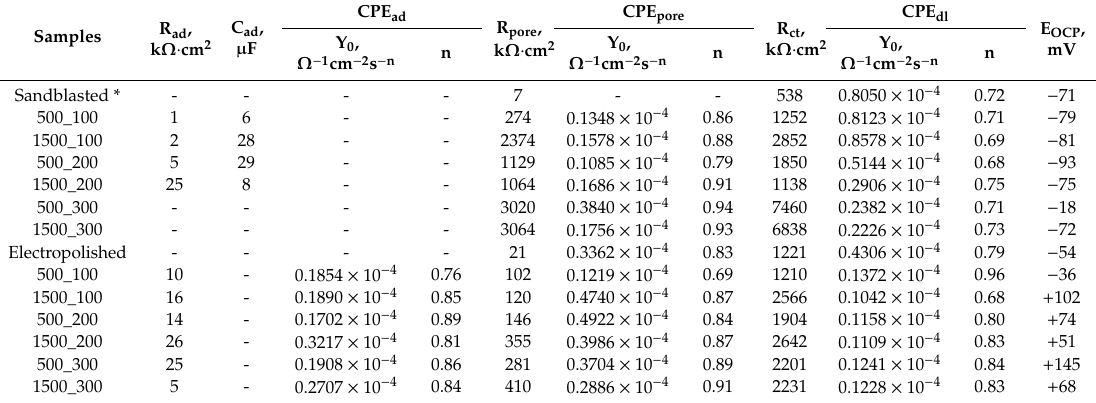
Table 2. Electrochemical Impedance Spectroscopy (EIS) results for the surface-modified 316LVM steel. Samples